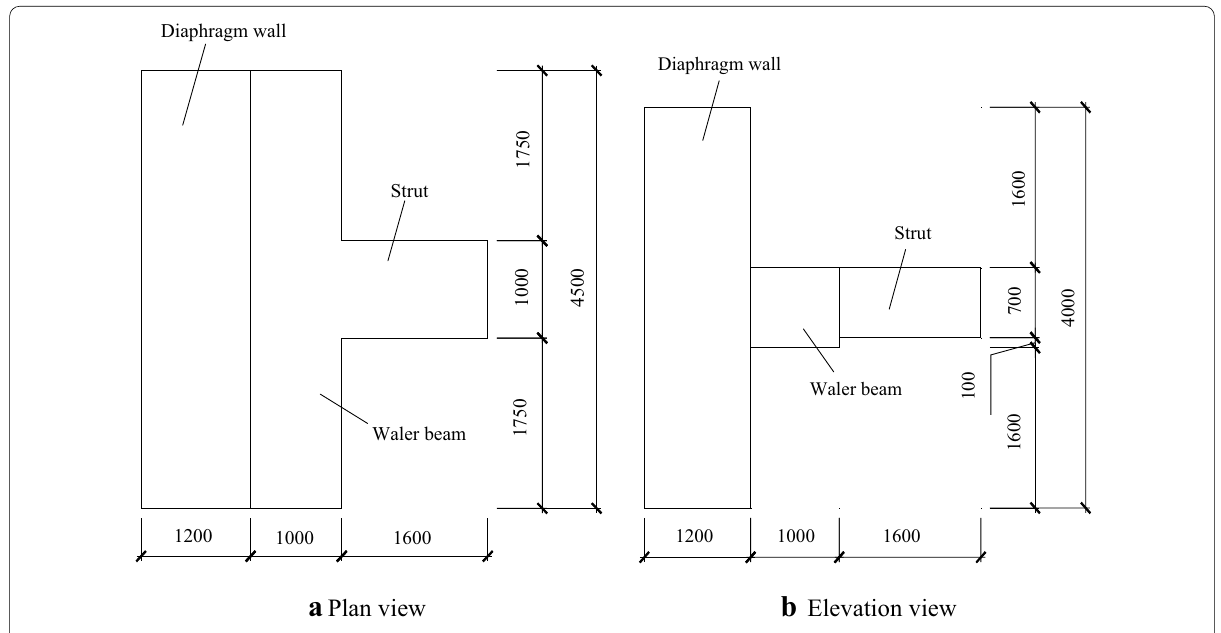
Fig. 5 Geometry and size of the specimens (unit: